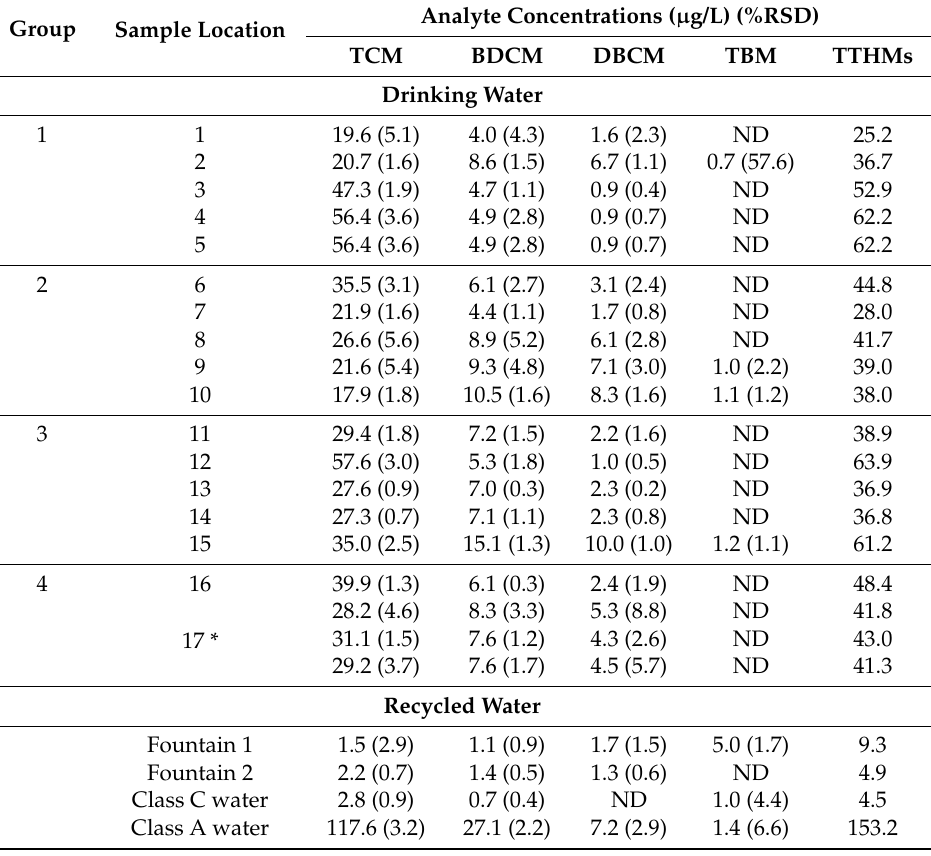
Table 3. Summary of THM occurrence data in analysed drinking and recycled waters.